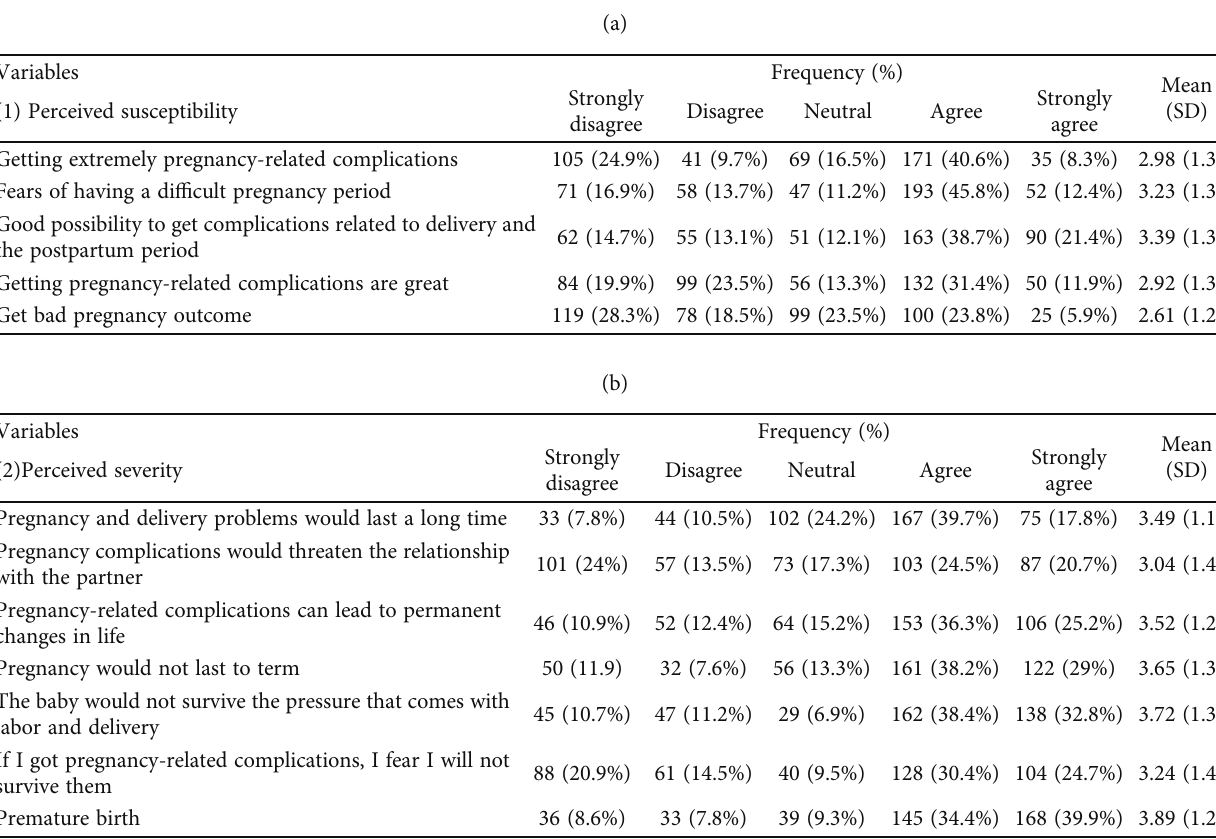
Table 4: Pregnancy risk perception of pregnant women attending antenatal care at Jabi Tehnan District health centers, Ethiopia in April 2021 ( n = 421